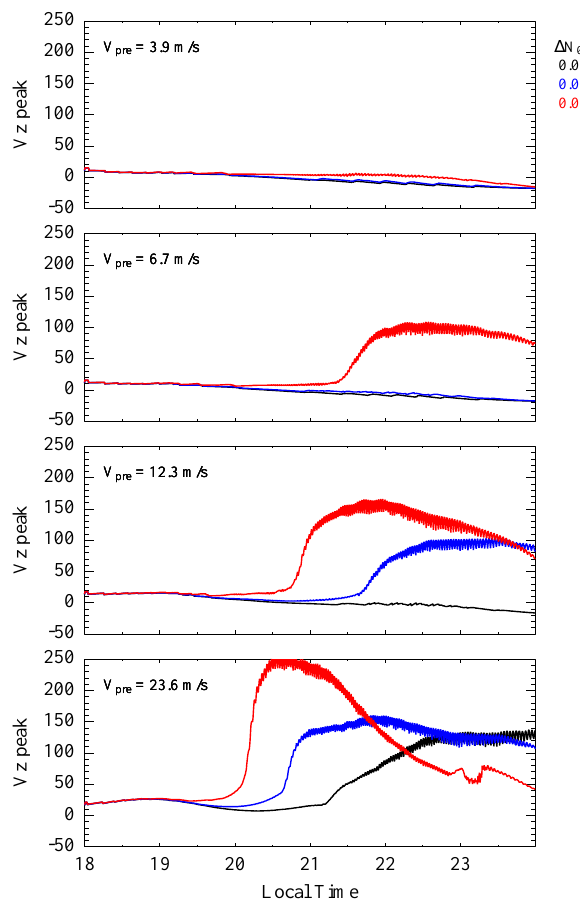
Fig. 1. The sensitivity of bubble development to the magnitude of the initial perturbation as well as the magnitude of the Rayleigh– Taylor growth rate. Vz peak is the maximum vertical velocity (in ms − 1 ) over the grid of the 2-D simulation of plume development; the upward jump in Vz peak indicates the formation of plumes. The panels of the plot show the results for the different prereversal ambi- ent drifts, which control the strength of the Rayleigh–Taylor growth rate. The different color curves represent the results of simulations with different initial magnitude perturbations: black, blue, and red represent a maximum perturbation 0.003, 0.01, and 0.03 times the peak ambient density,